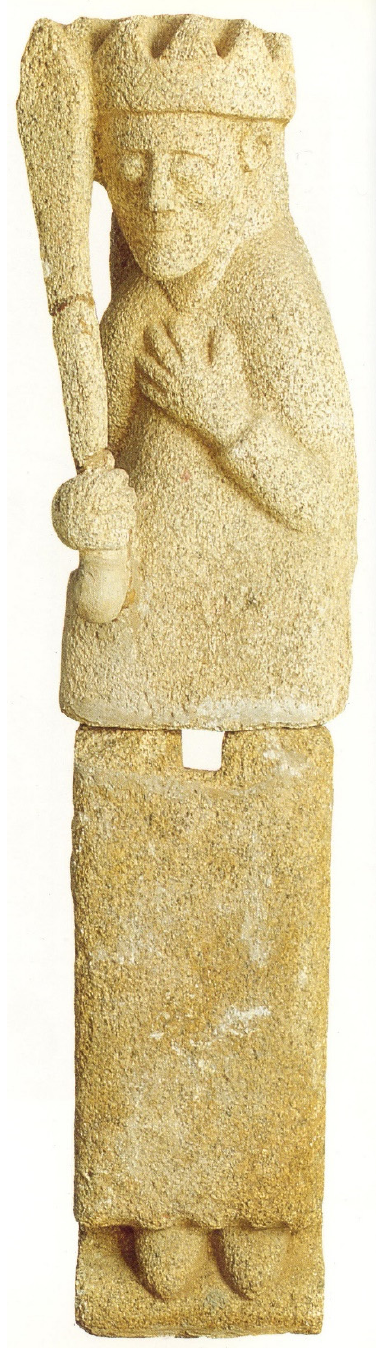
Figure 1. Afonso Henriques (?). 12th century. Church of the monastery of São Pedro de Rates.